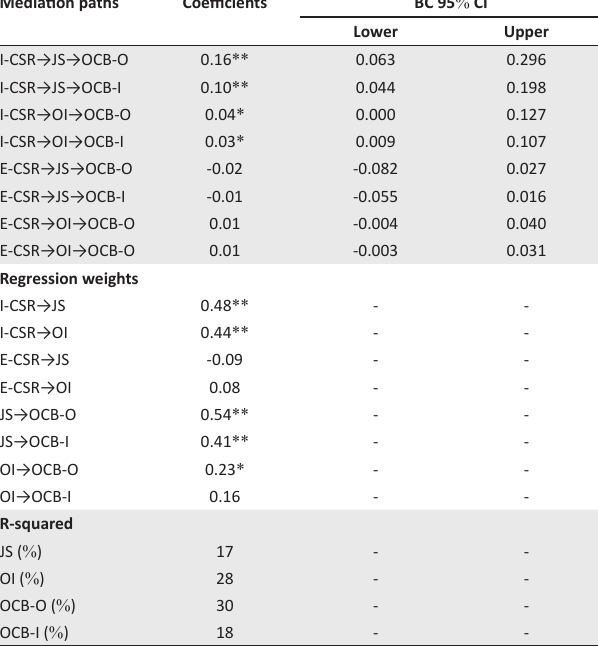
TABLE 4: Mediation analysis